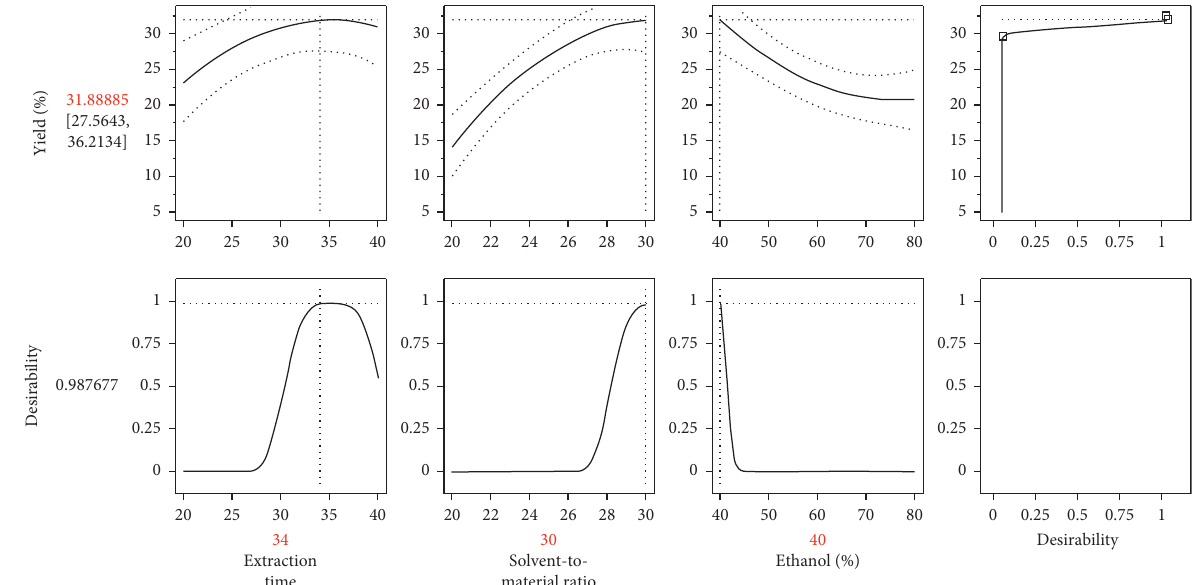
Figure 2: Desirability plot showing the precise operating conditions leading to the optimal